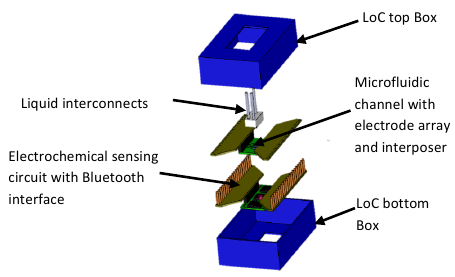
Figure 1. Proposed architecture of the PnP LoC design including microfluidics, interposers, electronics and packaging